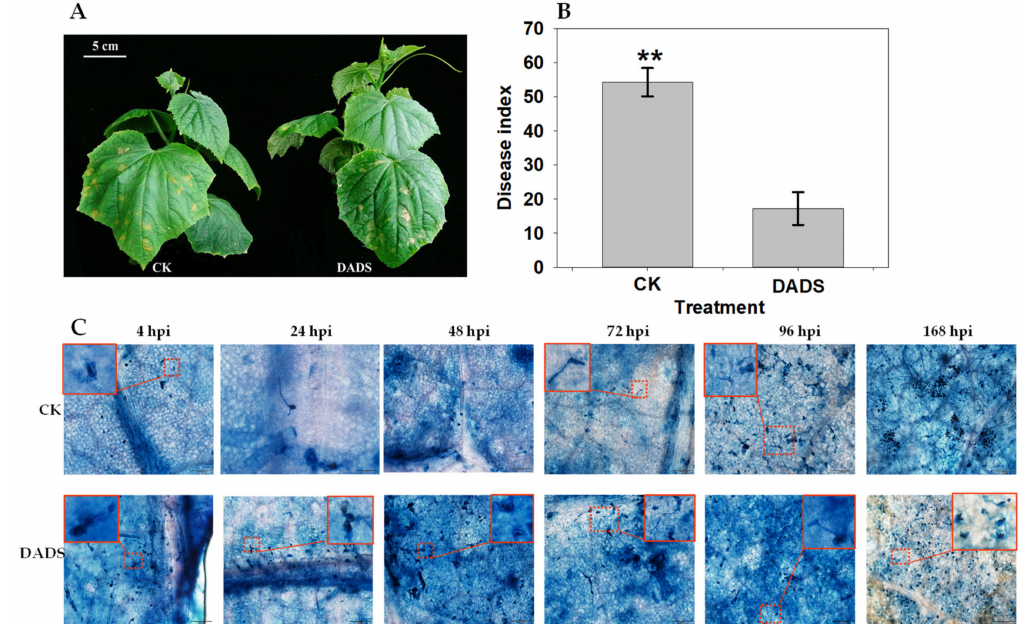
Figure 1. Comparison of leaf morphology ( A ), disease index ( B ), and process of P. cubensis infection ( C ) between DADS treated and CK cucumber seedlings. The inserted box in the top corner is a magnified image of the selected area. Data are means ± standard errors ( n = 3, three biological replicates). Asterisks indicate significant differences between DADS treatment and CK (** p < 0.01) based on a one-way ANOVA followed by a t -test. Scale bars: 5 cm ( A ), 100 µ m, 20 µ m ( C